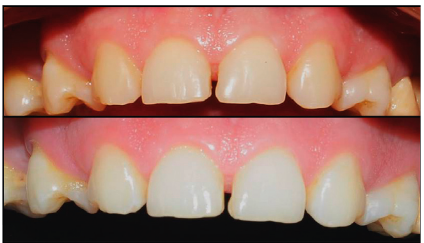
Figure 3: Result obtained after bleaching.